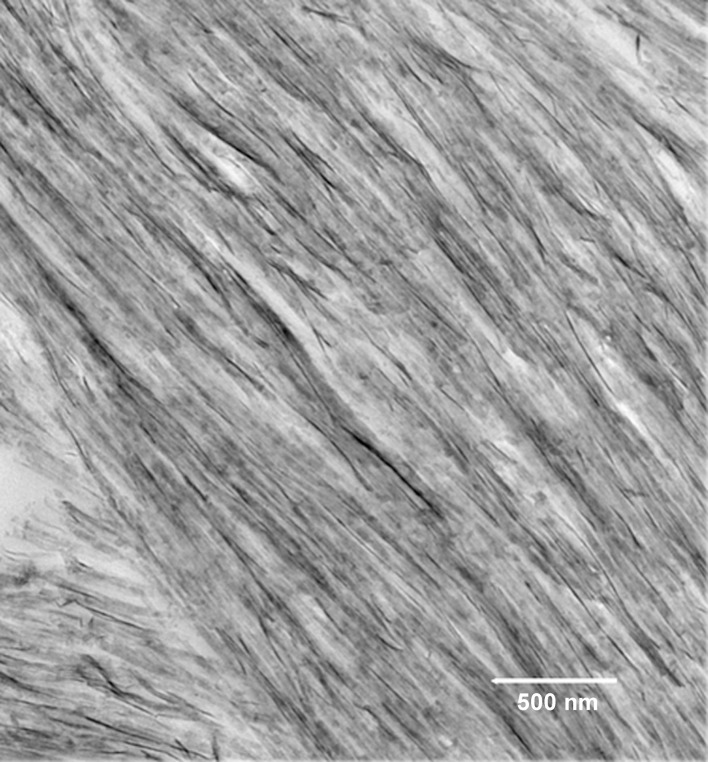
Transmission electron microscopy micrograph of secretory stage mouse enamel showing parallel arrays of long thin ribbons of mineral.